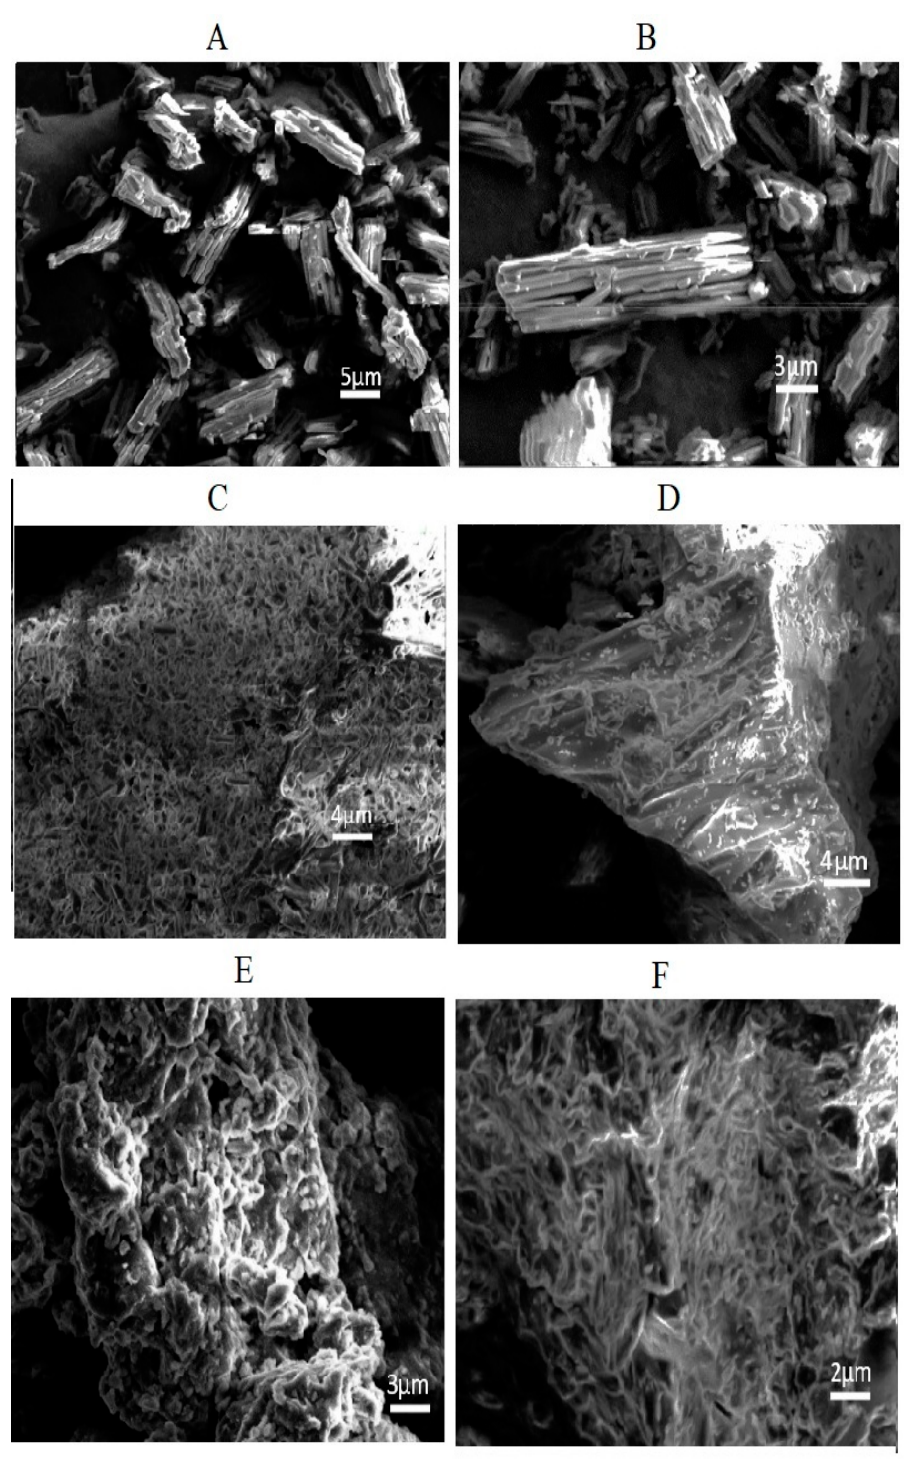
Figure 8. SEM micrographs of ( A , B ) pure Irbesartan, ( C ) S 1, ( D ) K 4, ( E ) KP407 (TD 3 ), and ( F ) KPVP (TD 3 )